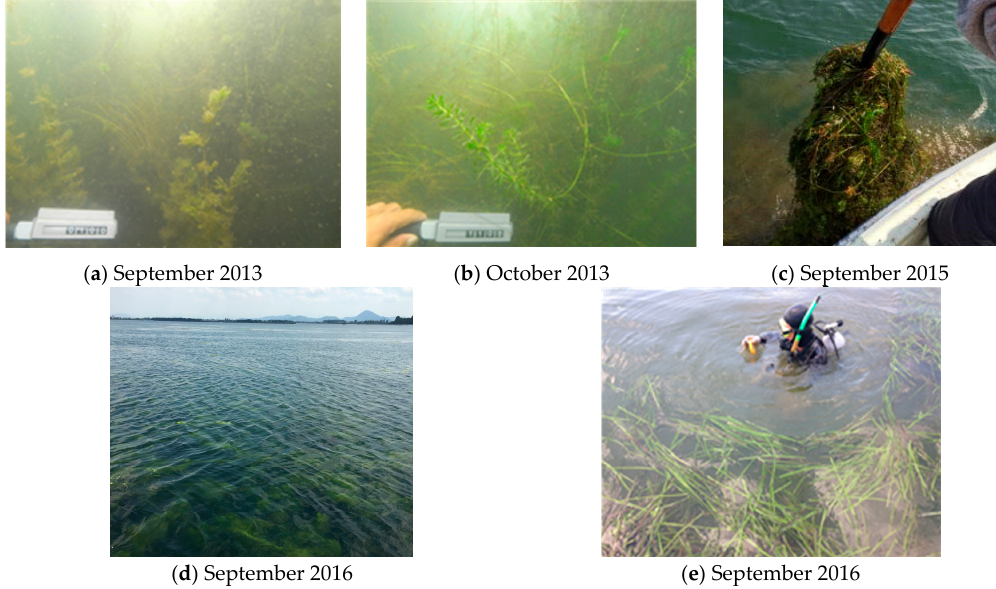
Figure 2. In-field images of the SAV in the south basin. The September and October 2013 images of the SAV at the lake bottom were provided by the Japan Water Agency ( a , b ). September 2015 and 2016 images were taken during field survey by LBERI ( c ) and September 2016 images were taken during the In situ measurement ( d , e ). LBERI: Lake Biwa Environmental Research Institute.